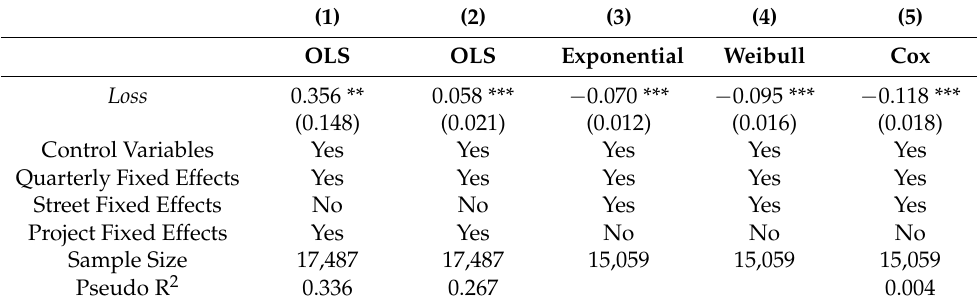
Table 9. Robustness analysis: different testing